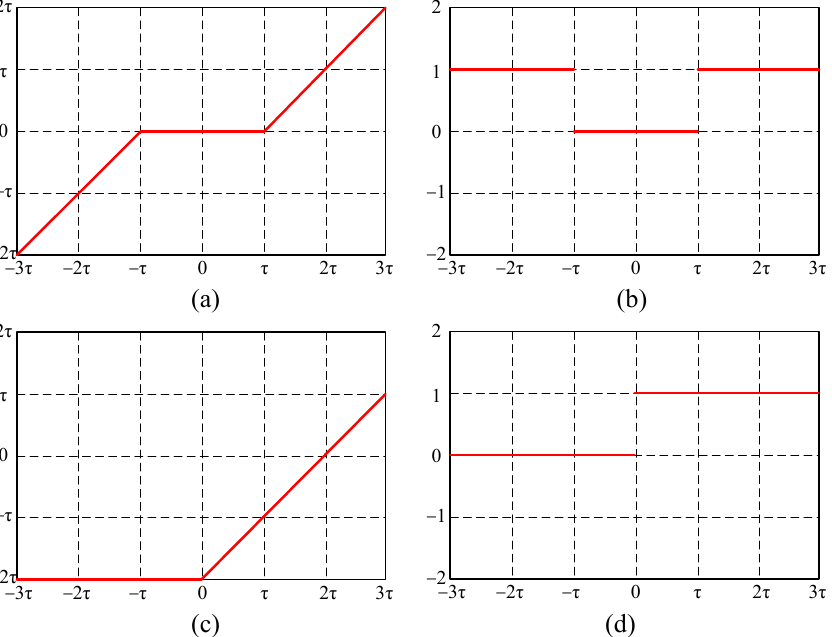
Figure 2. ( a ) Soft thresholding function, ( b ) derivative of the soft thresholding function, ( c ) ReLU function, and ( d ) derivative of the ReLU function.